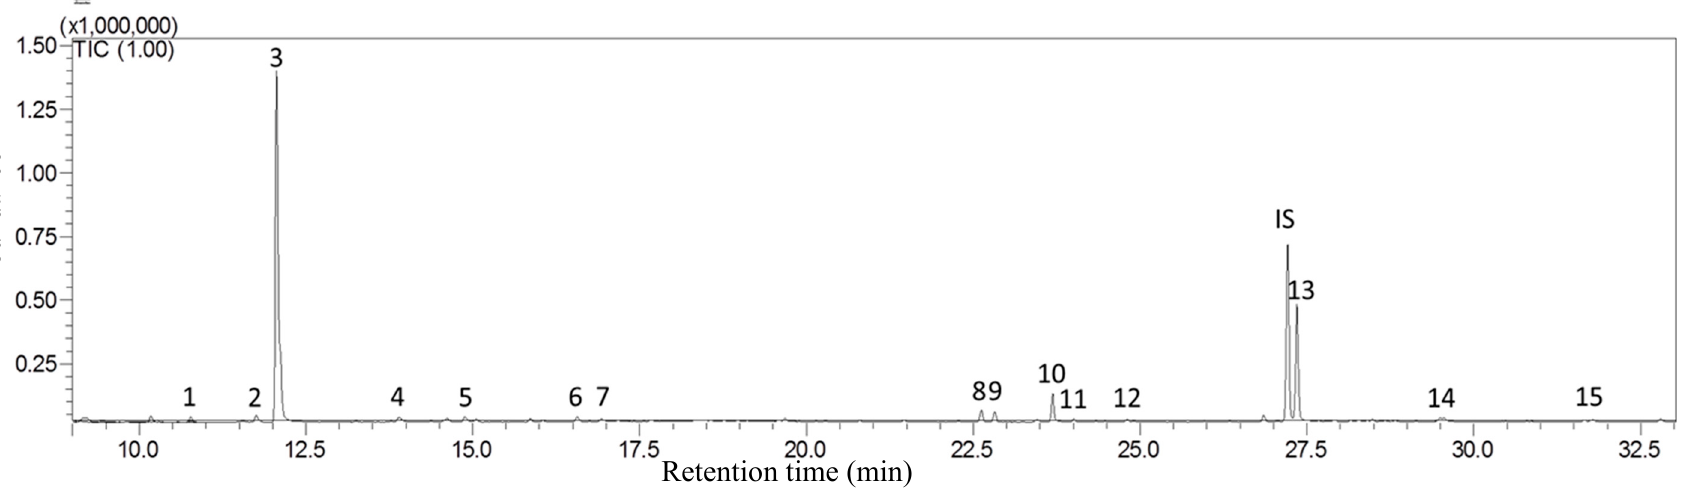
Figure 1. Gas chromatogram of all identified volatiles reflected in the 2nd instar larvae (IS: internal standard).